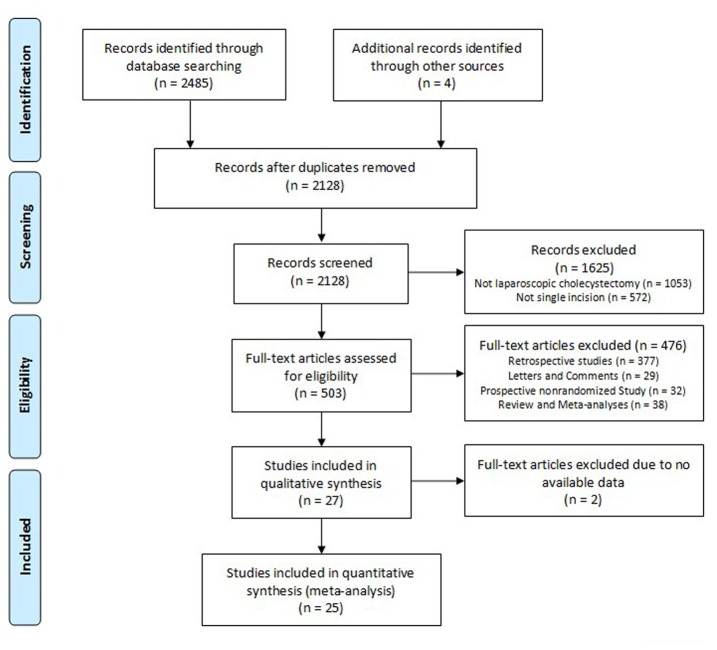
PRISMA flow diagram of the systematic article selection process.